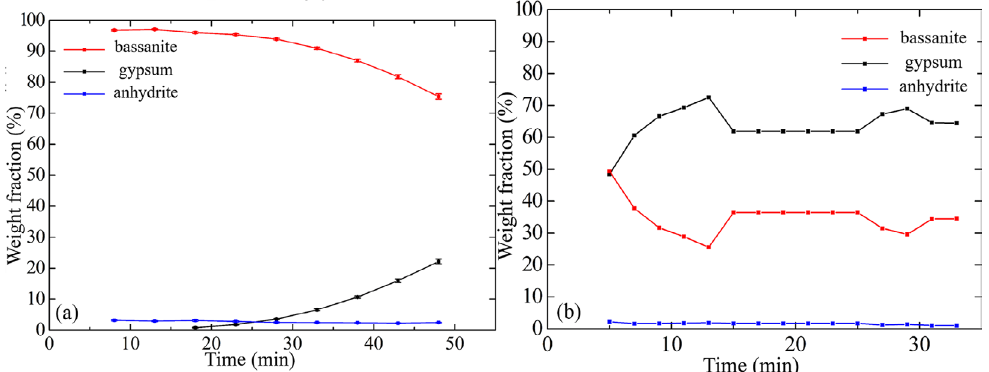
Figure 12. Mass fractions of the sulfate-based compounds (anhydrite - blue dots, bassanite - red dots, and gypsum - black dots) as a function of the hydration time of the samples (a) CP1 and (b) RP1 obtained by the sequential Rietveld refinement.